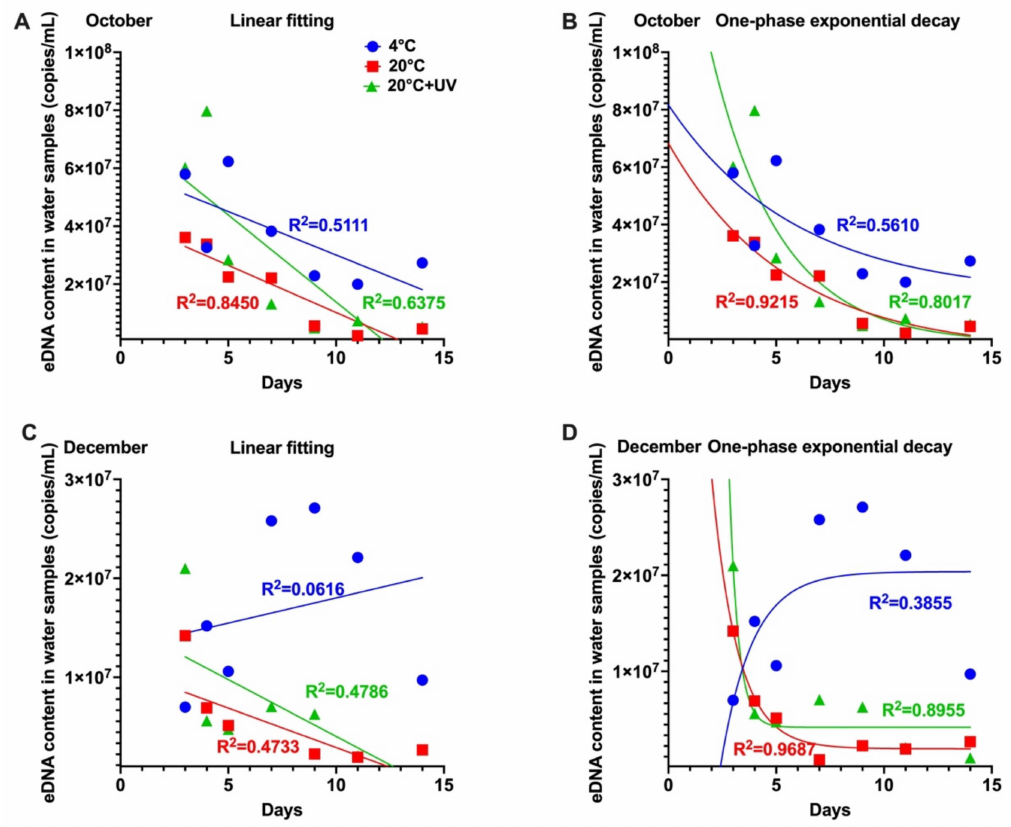
Figure 5. Relationship between residual eDNA content in the environment and decay time (from 3 days to 14 days) for 16S rRNA gene of prokaryotic DNA. ( A , B ) showed the linear fitting and one-phase exponential decay models in the October samples, respectively. ( C , D ) showed the linear fitting and one-phase exponential decay models in the December samples,